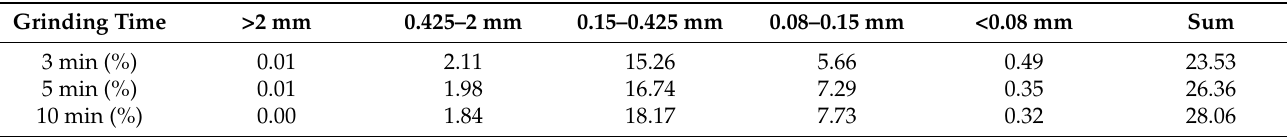
Table 4. AlN fractions of different particle sizes obtained by steel ball grinding.